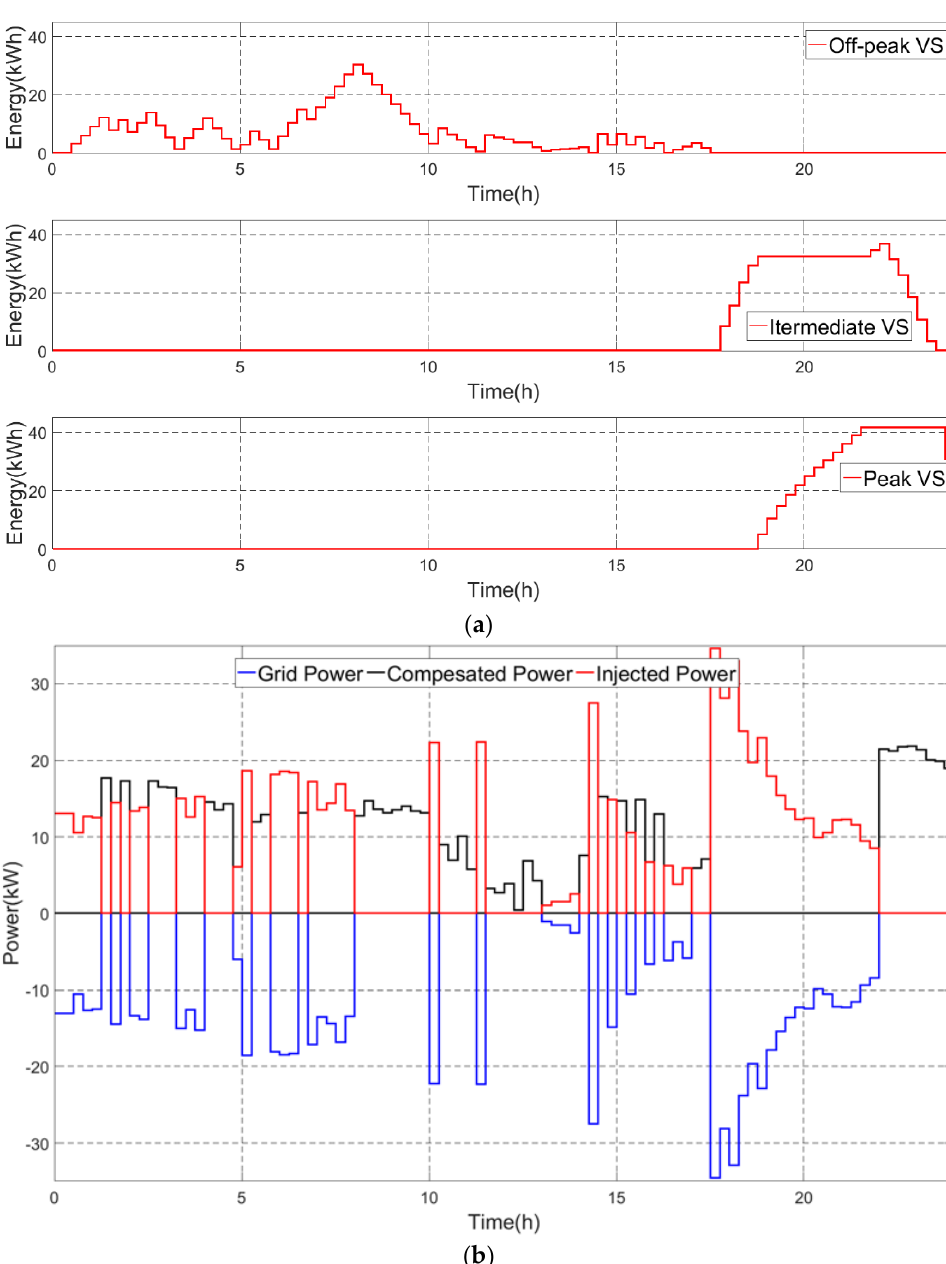
Figure 7. Scenario 1—( a ) Energy in virtual storage (kWh); ( b ) grid power. Grid (in blue), compensated (in black) and injected (in red) power (kW).